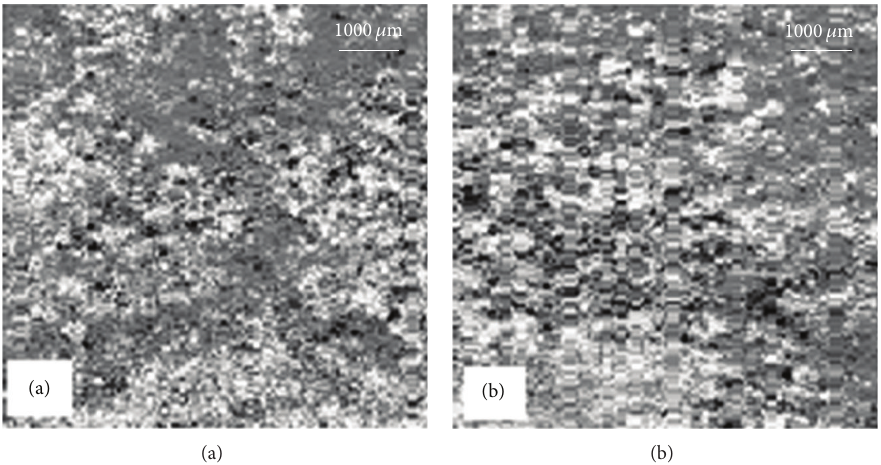
Figure 2: Microscopic images of histological sections of the biopsy of benign (a) and malignant (b) tumors of the uterus.